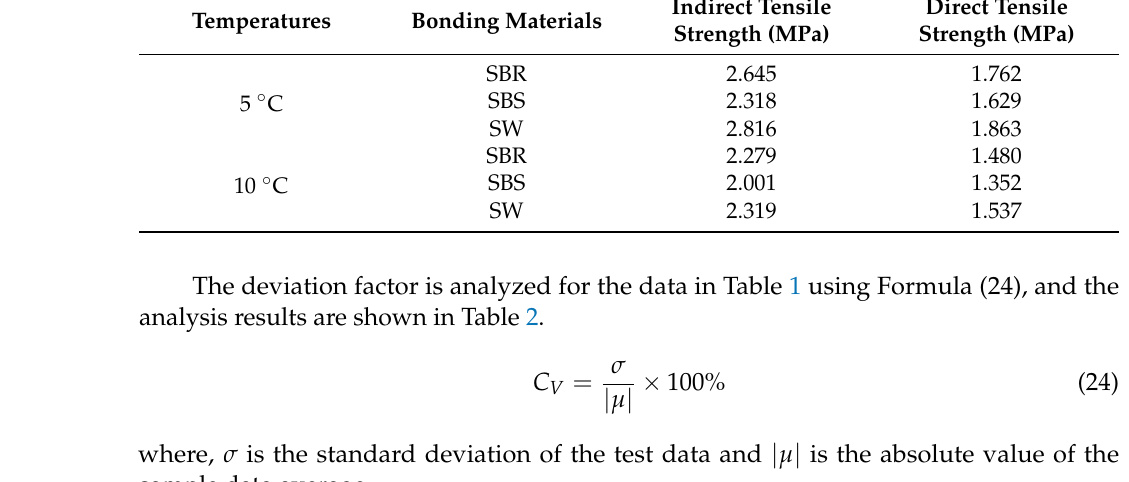
Indirect Tensile Direct Tensile Strength (MPa)